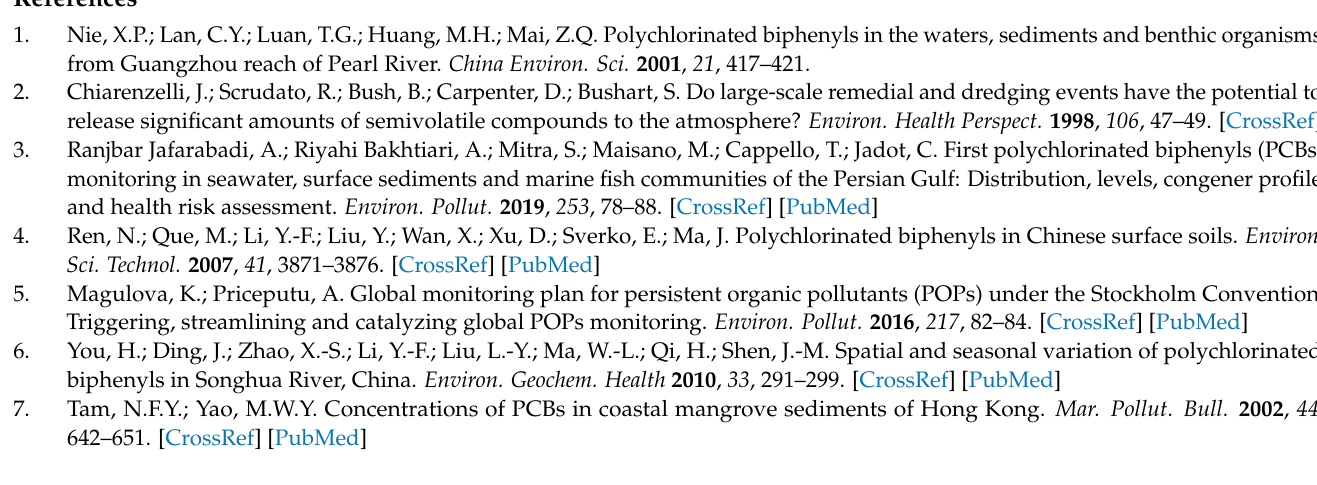
Table S1: Error estimation summary results in PMF model; Table S2: PCB concentration in sediment (dry soil: ng · g − 1 DW); Table S3: The homolog groups of detected